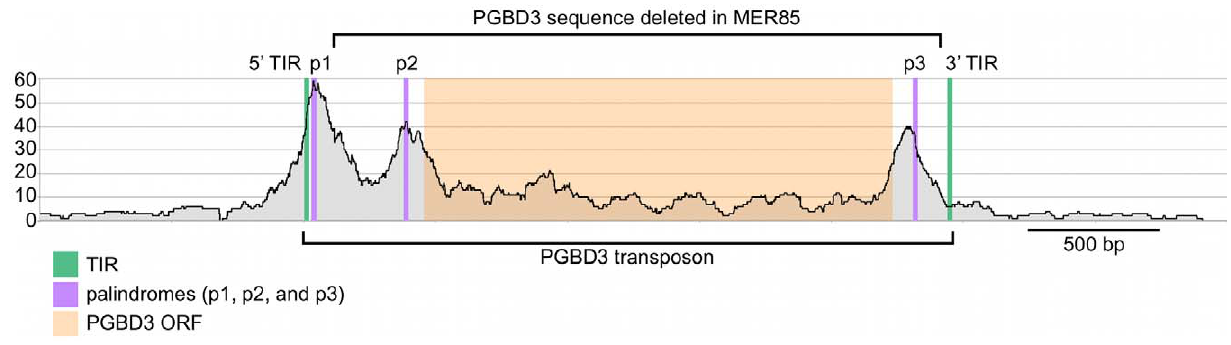
Figure 4. Fragment overlaps in the vicinity of the PGBD3 transposon reveal strong binding near each of three palindromes. Occupancy of CSB-PGBD3 near the PGBD3 transposon was assessed by counting the number of overlapping ChIPed fragments at each position. TIR, terminal inverted repeat; ORF, open reading frame. Ordinate indicates the number of overlapping fragments.